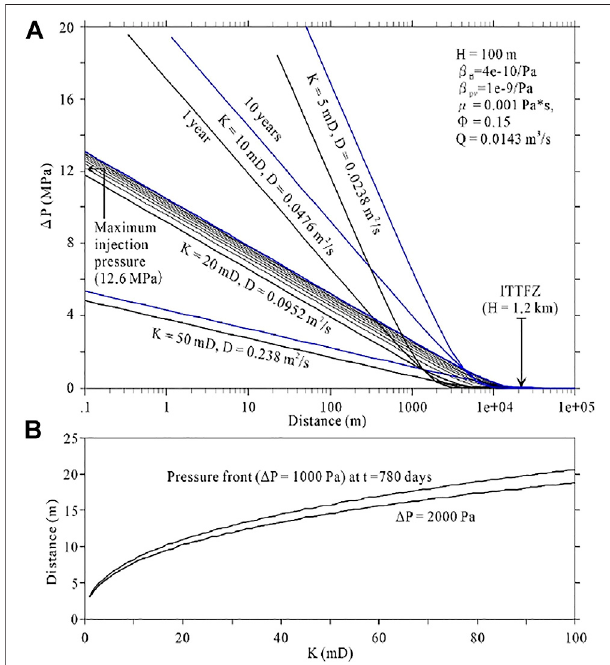
FIGURE 3 | (A) Increase in fl uid pressure as a function of distance from the injection well as estimated from two-dimensional radial fl owing model. (B) Pressure fronts after 780 days of continuous water